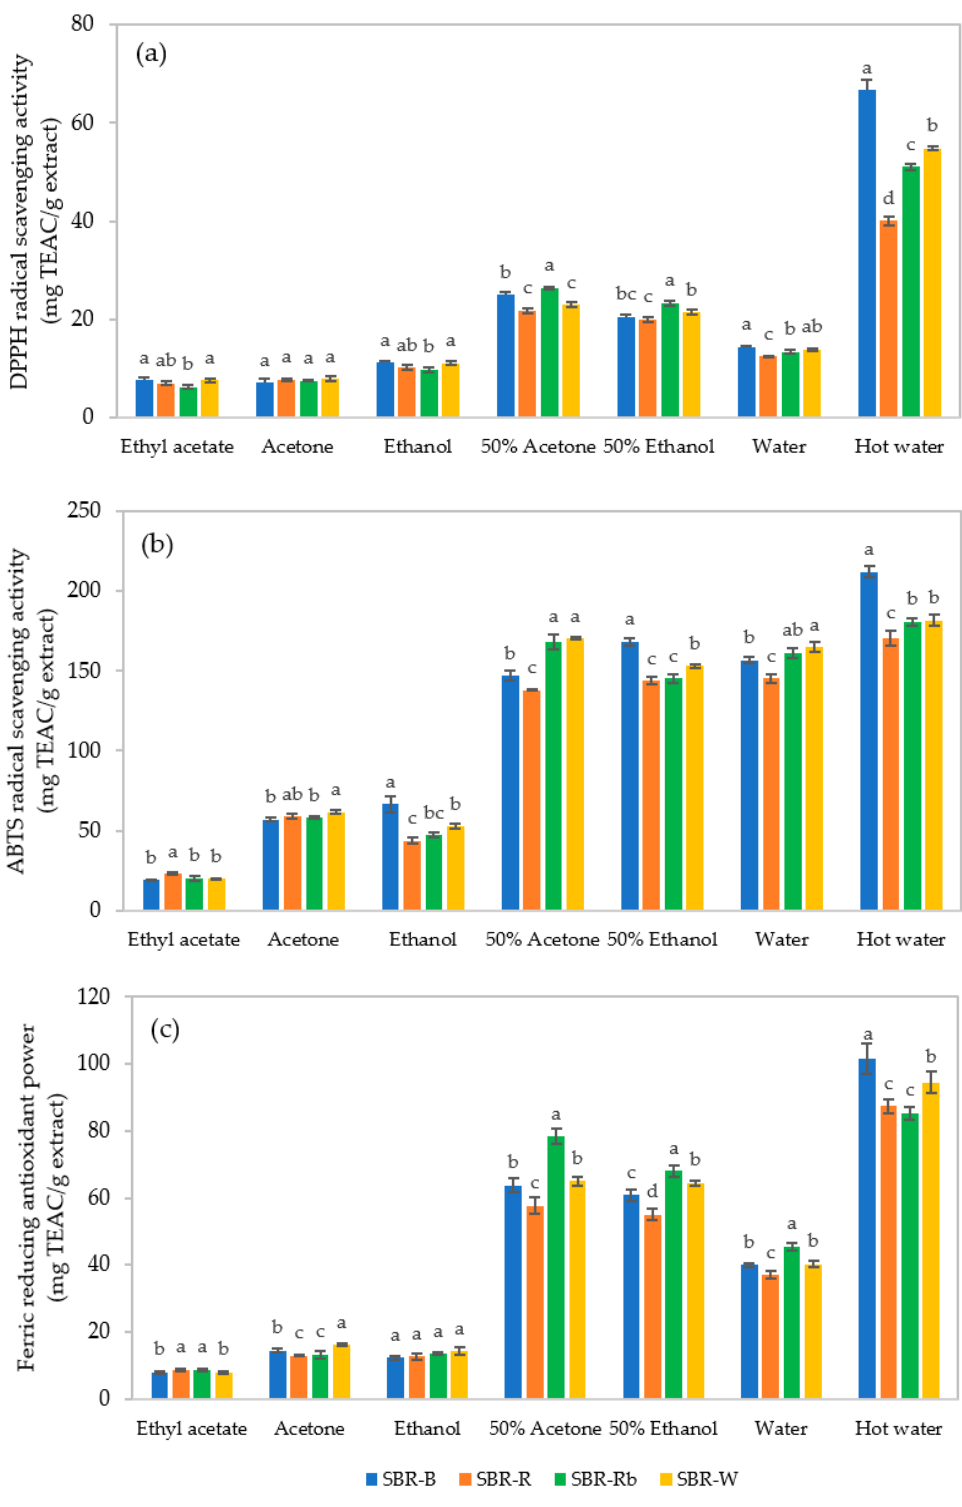
Figure 4 . Antioxidant activities of crude extracts prepared from solid-based residues (SBRs) using different solvents: ( a ) DPPH radical scavenging activity; ( b ) ABTS radical scavenging activity; ( c ) ferric-reducing antioxidant power (FRAP). Values compared for the same solvent with different superscript letters are significantly different based on Tukey’s test ( p < 0.05).